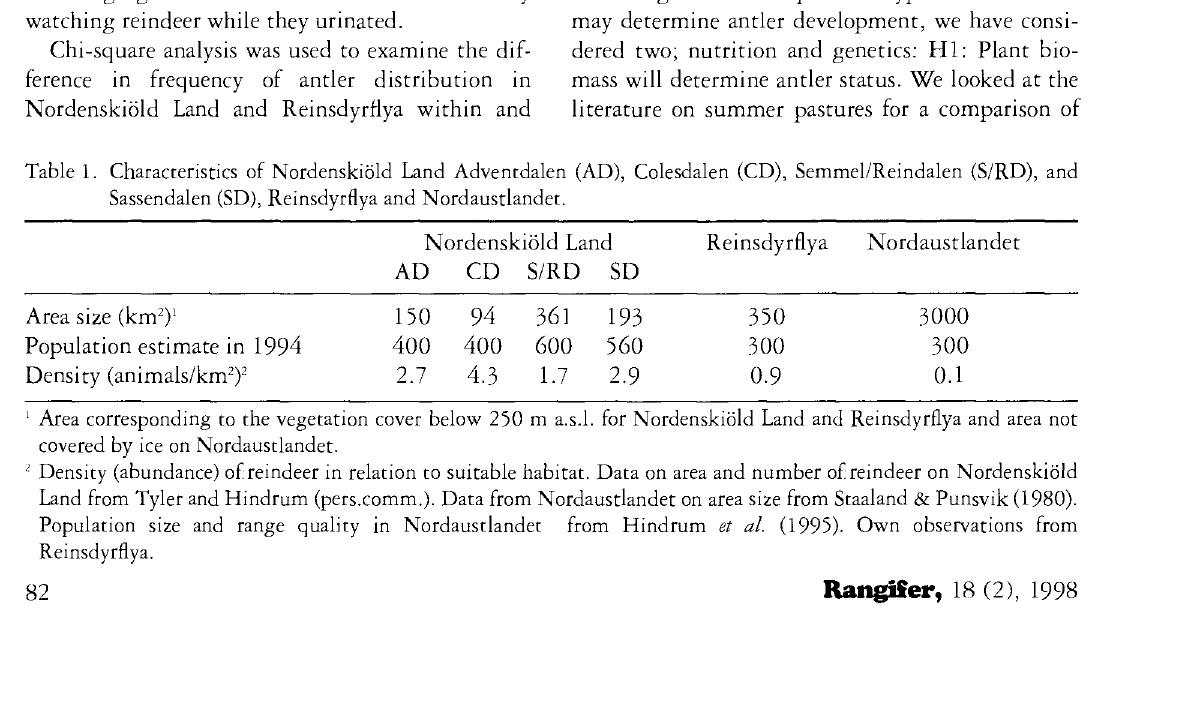
and Semmeldalen/Reindalen (Fig. 1, Table 1). Field work was conducted from the ground in July, 1994. Reindeer were categorized according to sex and age (calves and 1 yr+), and the presence/absence of antlers was recorded through direct observations of free ranging individuals. Sex was determined by watching reindeer while they urinated.